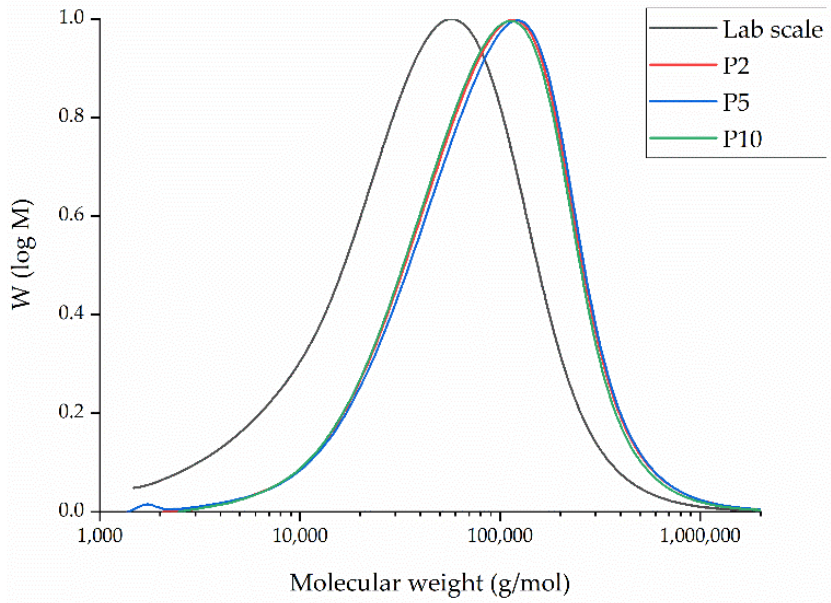
Figure 9. Molar mass distribution curves of PBS fibers from laboratory-scale (throughput of 0.1 mL/min) and pilot-scale 2 (P2), 5 (P5) and 10 (P10) rpm melt-electrospinning, both at 235 °C.